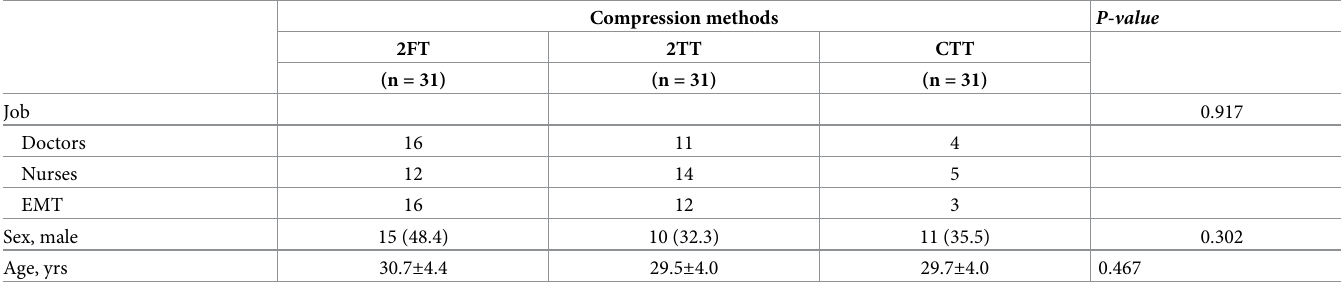
Table 1. General characteristics of participants.